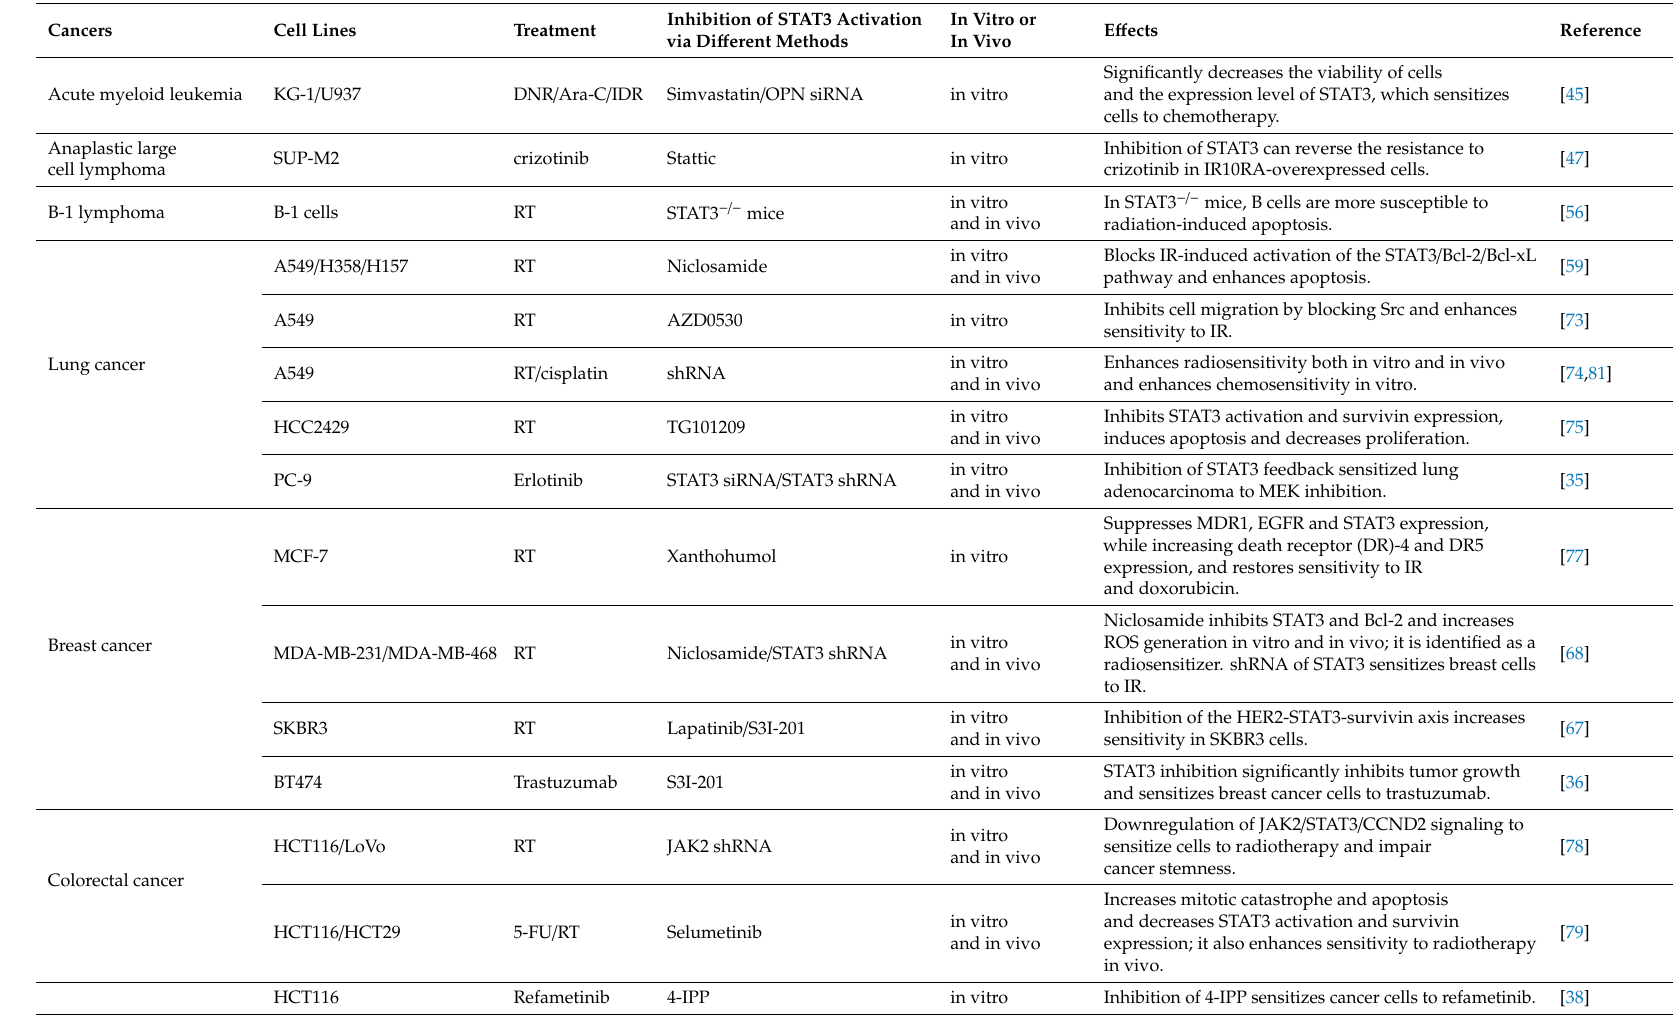
Table 1. STAT3 contributes to chemo(radio)resistance in various carcinoma